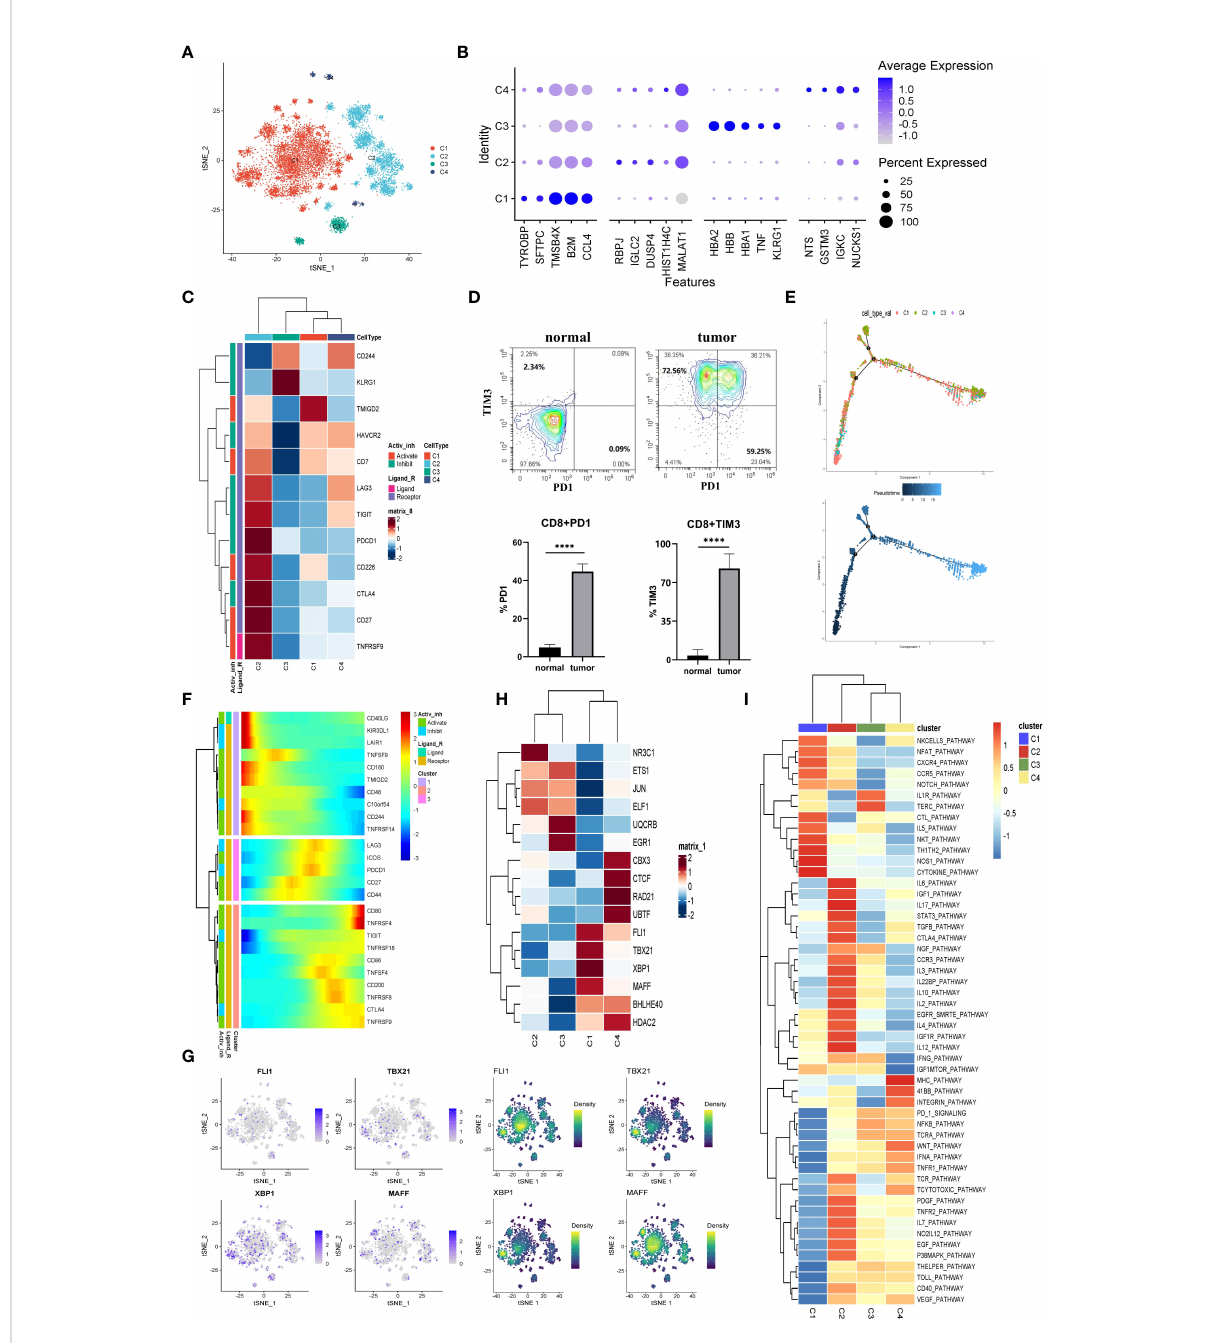
FIGURE 3 The CD8+ T cells in tumor TME preferred to be exhausted state. (A) The CD8+ T cells were subdivided into 4 clusters and represented on the tSNE plot. (B) The top fi ve markers of the four major cell clusters were shown on the dot plot; the color represented expression level, while the sizes of dots represented abundance. (C) The heatmap demonstrated the downregulated or upregulated immune checkpoints in exhausted T cells. The expression level was represented by a row Z score. (D) The exhausted T cells in LUAD were analyzed by fl ow cytometry. The PD1+CD8+ and TIM3 +CD8+ T cells demonstrated speci fi cally enrichment in LUAD specimens. Gate from CD8+T cell, ****p<0.0001.. (E) The CD8+ T cells ’ differentiation trajectory in LUAD and normal tissue and the color represented for clusters (up) or pseudotime (down). (F) The pseudo-heatmap showed the variation of immune checkpoint genes expression with the CD8+ T cells differentiation in LUAD, which could be subgrouped into three subcategories. (G) The tSNE plot represented the expression level of the indicated transcription factors (left) and the estimated AUC for these transcription factors ’ activity (right). (H) The heatmap showed the transcription factors ’ activity through SCENIC estimated AUC scores. (I) Heatmap of differences in activities of immune-related signaling pathways scored by